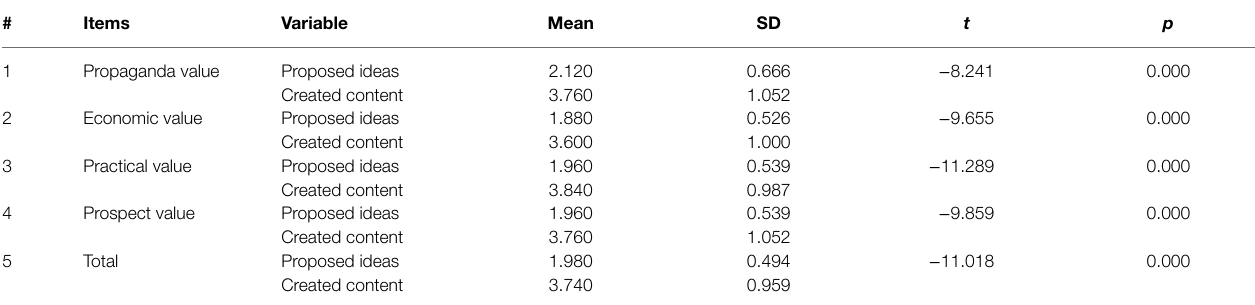
TABLE 10 | Changes in entrepreneurship: evaluation of proposed ideas and created content and their